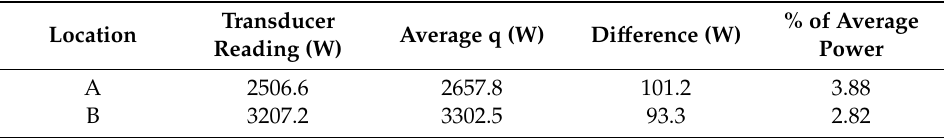
Table 1. Heat balance